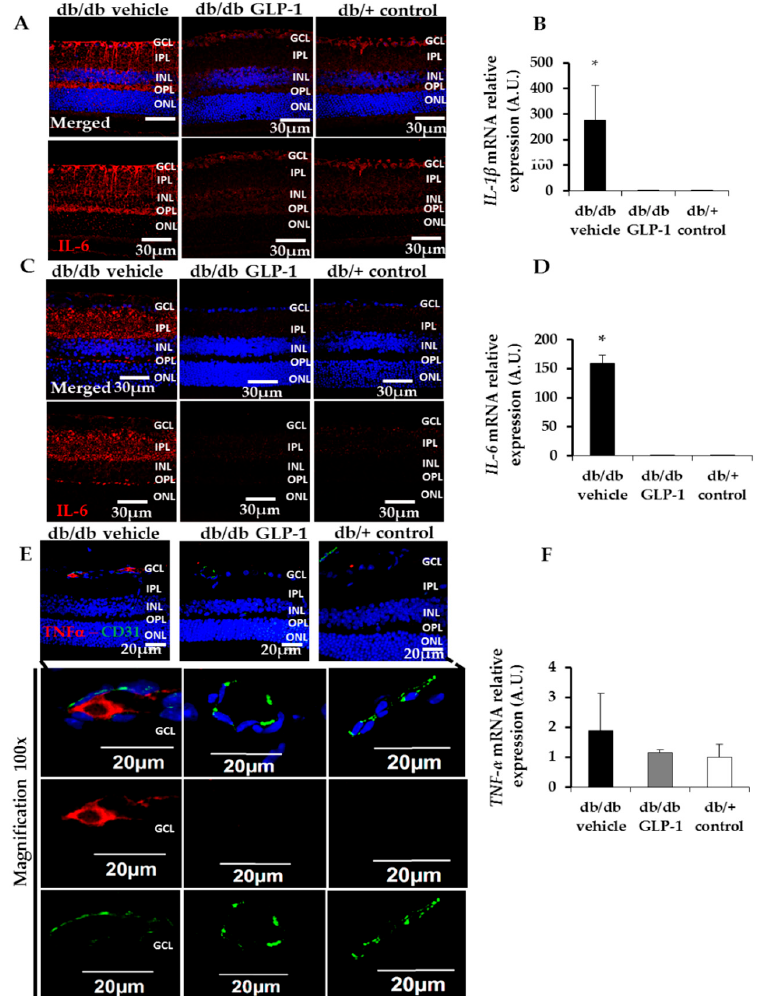
Figure 6. ( A ) Immunofluorescence of IL-1 β . Scale bars, 30 µ m. Nuclei were labelled with Hoechst stain (blue); ( B ) Real-time quantitative reverse transcription polymerase chain reaction (RT-PCR) analysis of IL-1 β in db/db mice treated with vehicle (black bars), db/db mice treated with glucagon-like peptide-1 (GLP-1) eye drops (grey bars) and non-diabetic mice (white bars), n = 4. * p < 0.01 db/db vehicle in comparison with other groups; ( C ) Immunofluorescence of IL-6 . Scale bars, 30 µm. Nuclei were labelled with Hoechst stain (blue); ( D ) Real-time quantitative RT-PCR analysis of IL-6 in db/db mice treated with vehicle (black bars), db/db mice treated with GLP-1 eye drops (grey bars) and non-diabetic mice (white bars), n = 4. * p < 0.01 db/db vehicle in comparison with other groups; ( E ) Immunofluorescence of colabelling TNF- α /CD31. Scale bars, 30 µ m. Nuclei were labelled with Hoechst stain (blue); ( F ) Real-time quantitative RT-PCR analysis of TNF- α in db/db mice treated with vehicle (black bars), db/db mice treated with GLP-1 eye drops (grey bars) and non-diabetic mice (white bars) n = 4. GCL, ganglion cell layer; INL, inner nuclear layer; IPL, inner plexiform layer; ONL, outer nuclear layer; OPL, outer plexiform layer.